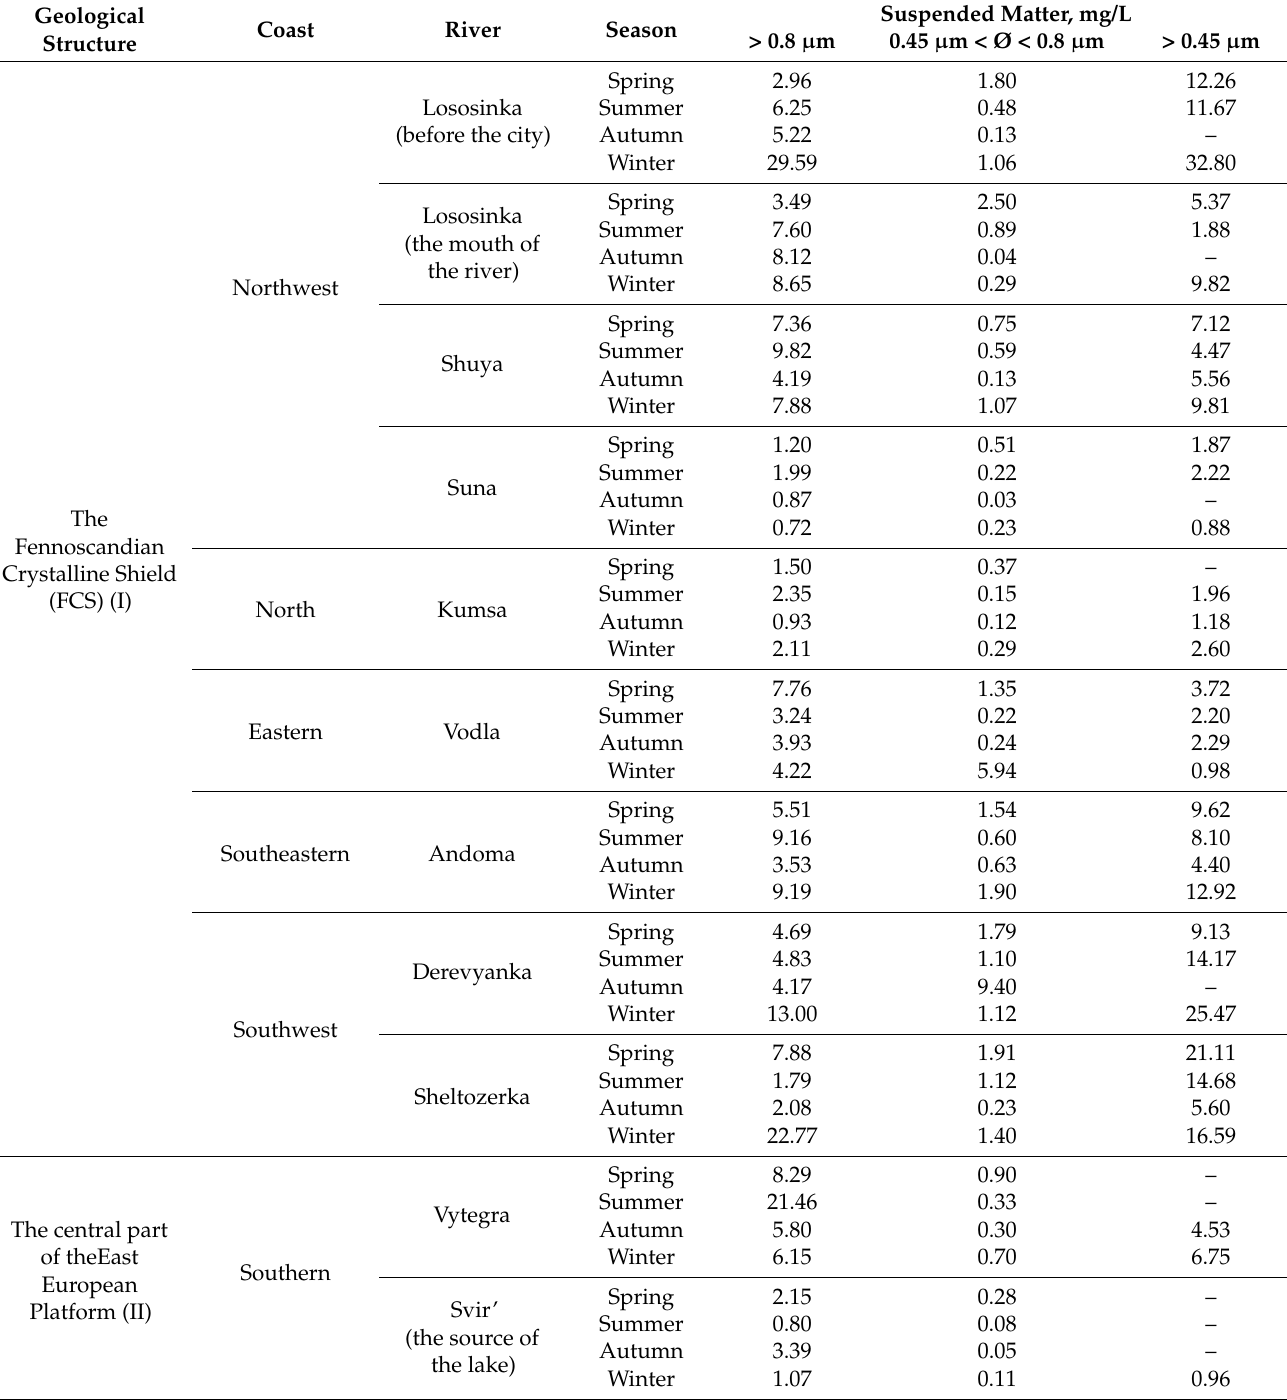
Table 5. Seasonal variations of suspended matter content in the surface water layer of the tributaries of Lake